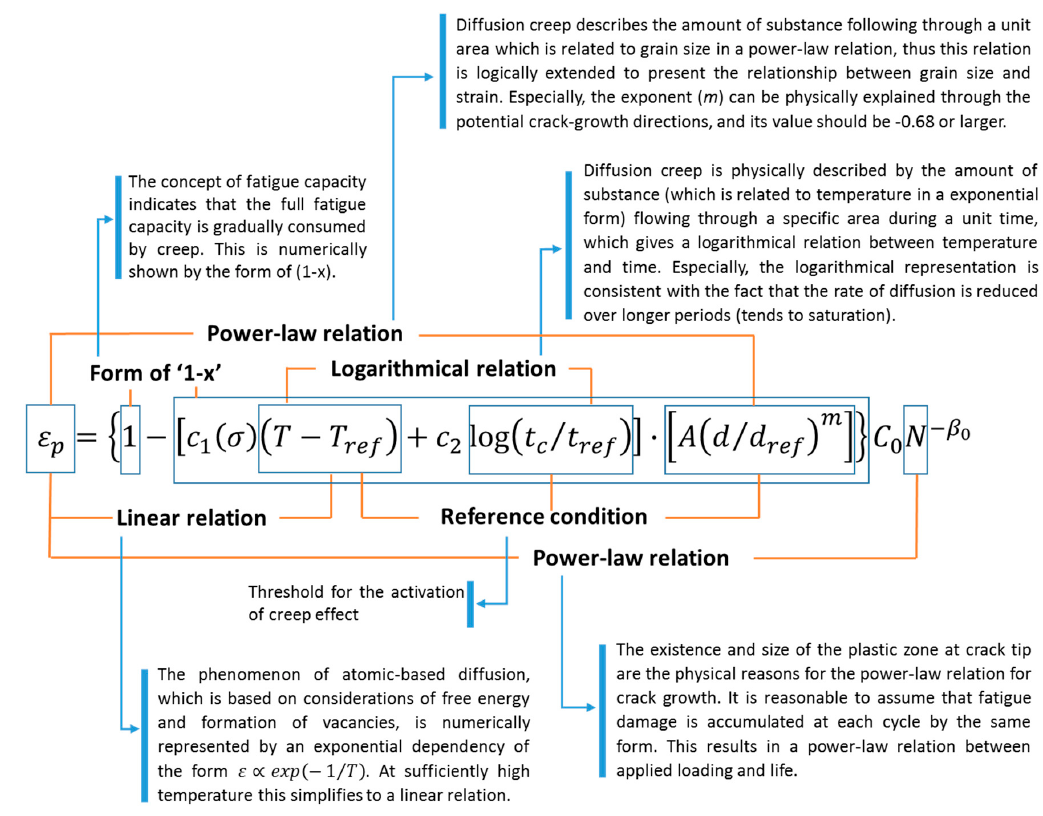
Figure 9. Main relationships and fundamental mechanisms in the unified formulation.